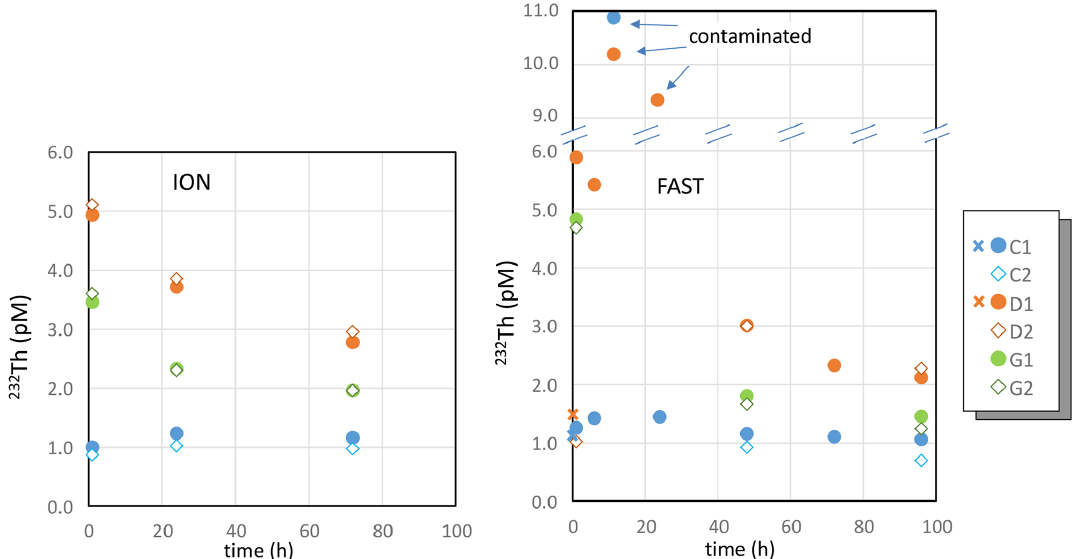
Figure 3. Dissolved 232 Th during the ION and FAST experiments. Note the break in the y axis so as to include values of the three outliers (contaminated samples). Crosses correspond to samples collected before dust addition ( t = 0).